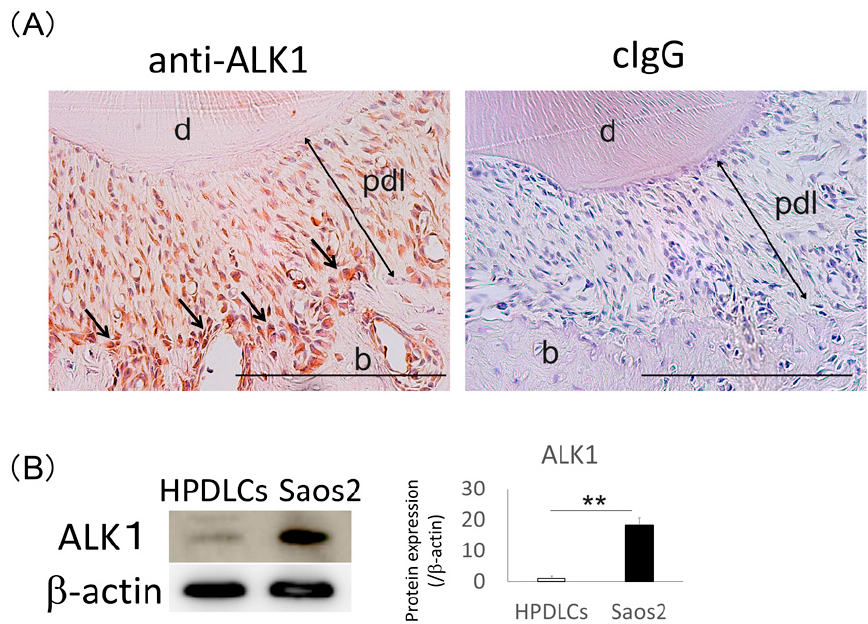
Figure 4. Expression of ALK1 in normal rat periodontal ligament (PDL) tissue and Saos2 cells. ( A ) Immunohistochemical analysis was performed using an anti-ALK1 antibody in rat PDL tissue. Positivity to an anti-ALK1 antibody was detected in PDL tissue, and ALK1-immunoreactive cells were localized in the osteoblastic layer (arrows). Control IgG was used for a negative control. Hematoxylin was used for the staining of nuclei. Experiments were performed in duplicate. b, alveolar bone; d, dentin; pdl, periodontal ligament. Bars = 500 µm. ( B ) Western blotting analysis was performed to detect expression of ALK1 in human PDL cells (HPDLCs) and Saos2 cells. The expression levels of this protein were normalized against β -actin expression and were quantified. The expression level of ALK1 was higher in Saos2 cells than in HPDLCs. Values are the means ± SD from three independent experiments. ** p < 0.01.